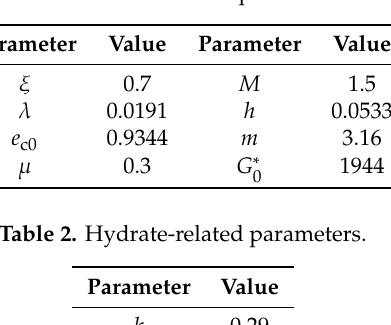
Table 1. Sand material parameters.